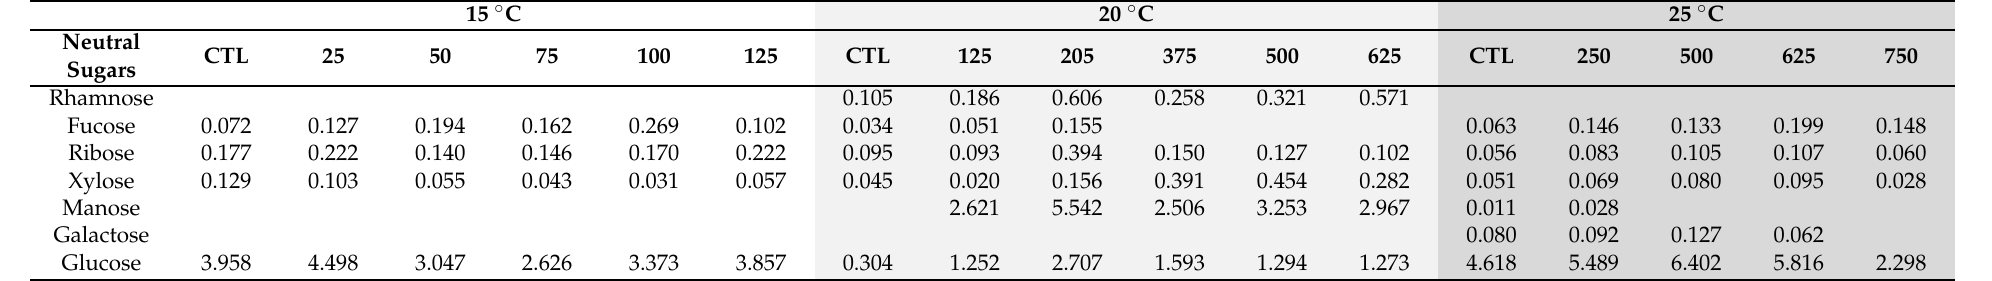
Table 7. Neutral sugar quantification ( µ g/10 4 cell) of Thalassiosira weissflogii , determined in organisms after 7 days of exposure to different copper sulfate concentrations ( µ g/L) and